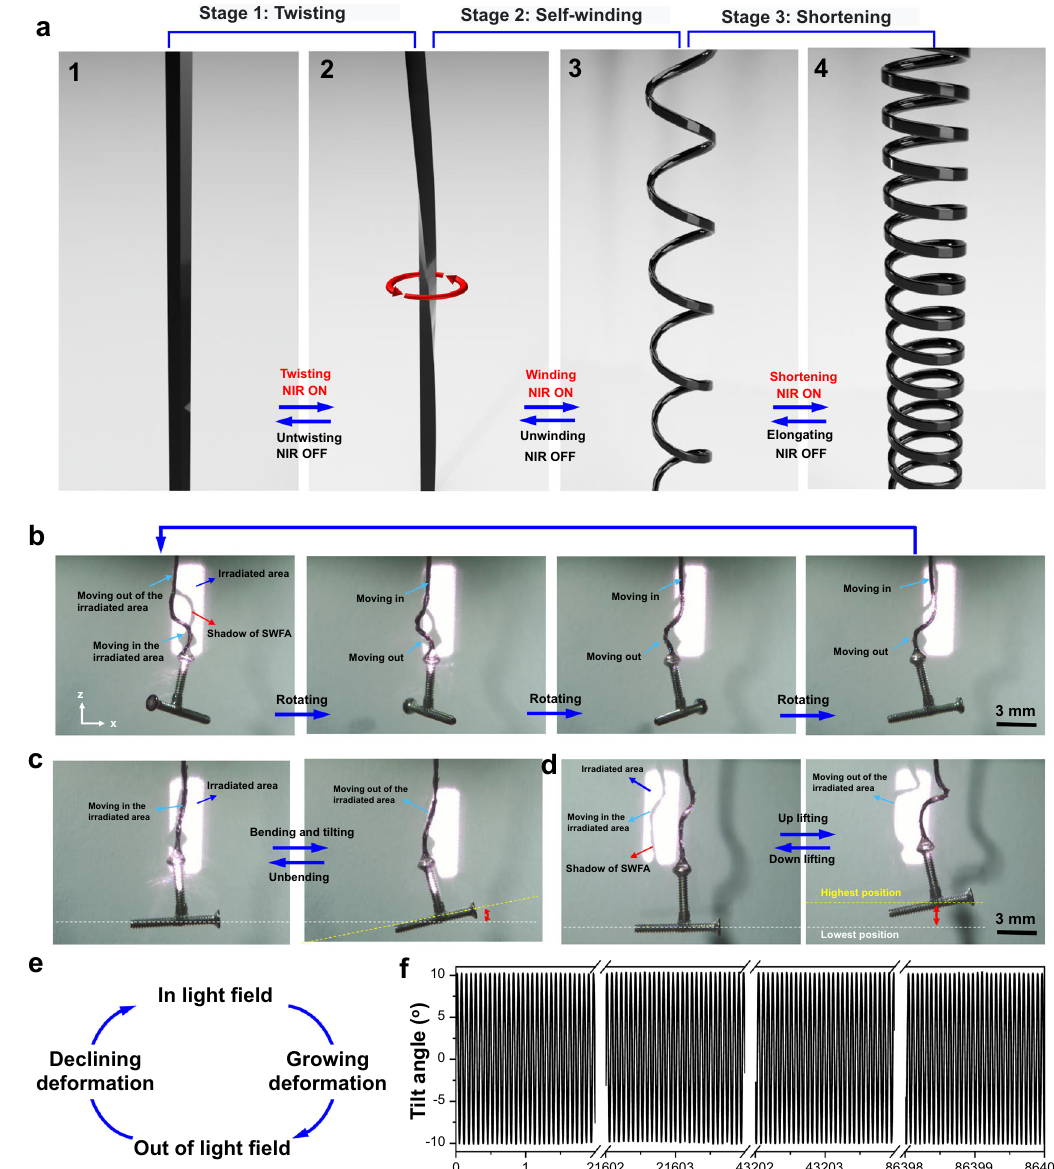
Fig. 3 Mechanism of phototunable self-oscillations. a Schematics showing the deformation and morphology change of SWFA in three stages upon NIR irradiation. It is assumed that the upper end of SWFA is fi xed, while the lower end hangs a load. Stage 1, SWFA contracts and twists; Stage 2, the twisted SWFA bends and self-winds into coils; Stage 3, the coiled SWFA shortens the distance between the coils. b , c , d Snapshots recorded by high-speed camera showing the irradiated SWFA moving in and out of the light fi eld during rotational oscillation, tilted oscillation, and up-and-down oscillation, respectively (Supplementary Movie 7). Through the location of the shadow of the irradiated SWFA in the light spot, the cycle motion of moving in and out of the light fi eld can be clearly observed. e Feedback loop created by the cycle motion of moving in and out of the light fi eld. f A total of 1,270,000 cycles of tilt oscillation in 24 h without obvious Fig. 3b – d, the deformation and morphological change of the SWFAs upon NIR irradiation make a part of the irradiated SWFAs moving out of the NIR fi eld (Supplementary Movie 7).